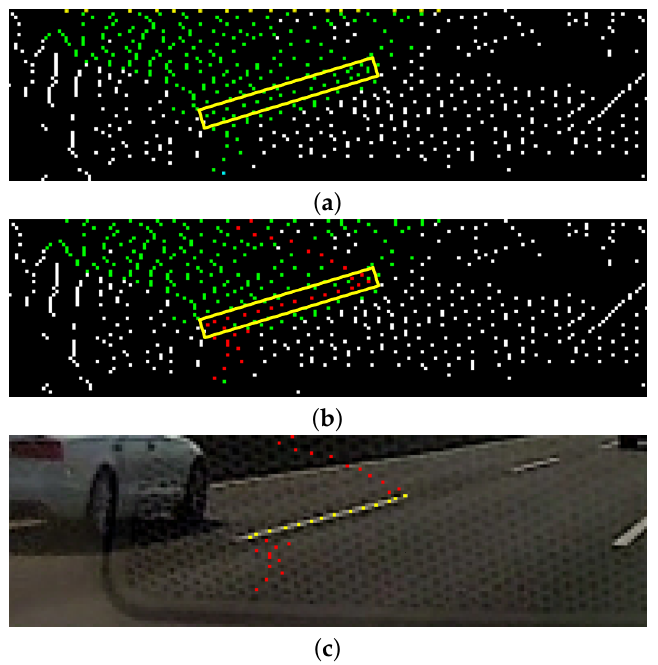
Figure 6. Examples of lane-marking line segments construction: ( a ) white and green points represent p k and p t v , respectively. Yellow points (from top row) and one cyan point (from bottom row) denote leaf nodes and a root node of the g t , respectively. A yellow rectangle depicts a region where a real lane marking exists; ( b ) an optimal path corresponding to g t is marked with red points; and ( c ) opt points that make up a LaLi are depicted as yellow points on the real input